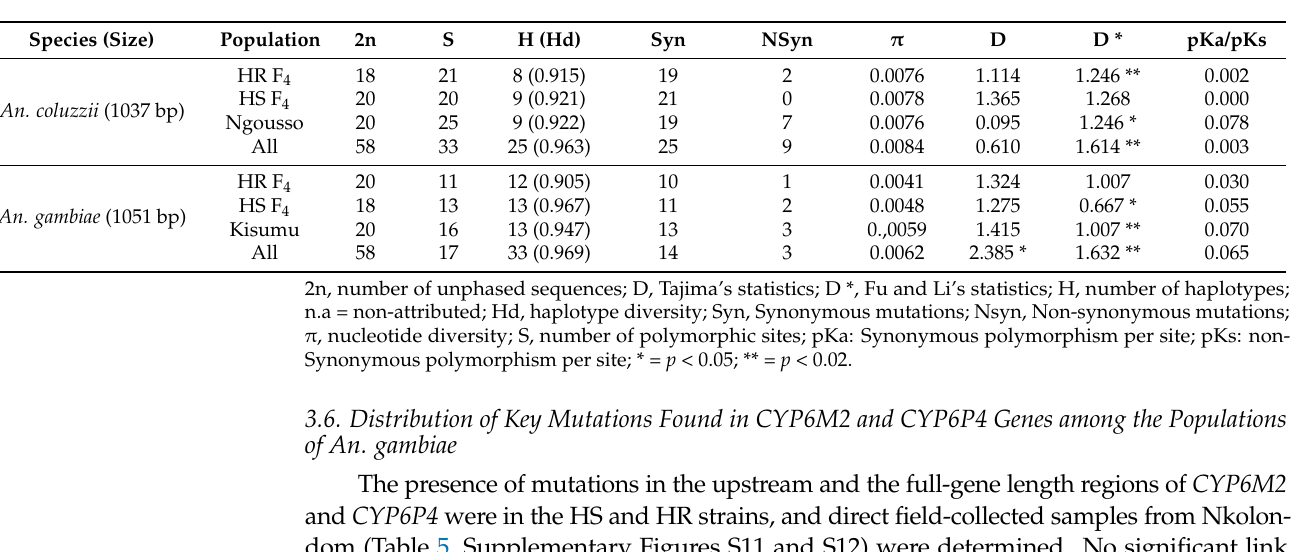
Table 4. Summary statistics for polymorphism of CYP6P4 -gene in permethrin highly susceptible and highly